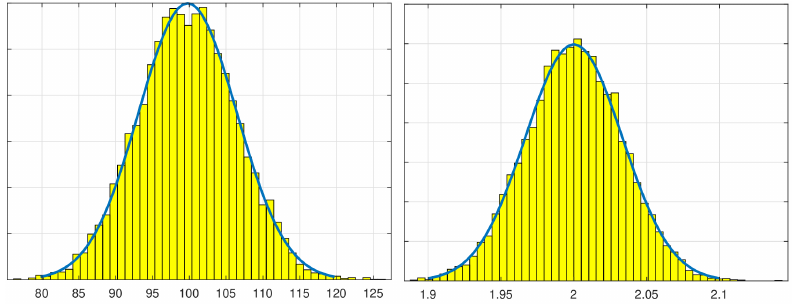
Figure 10. Frequency histogram for the normal distribution of parameters d (in Nms/rad) and Ja (in kgm 2 ) for the Monte Carlo analysis of the example model with 10,000 simulation runs. The plot shows the sampled frequency for each parameter value.